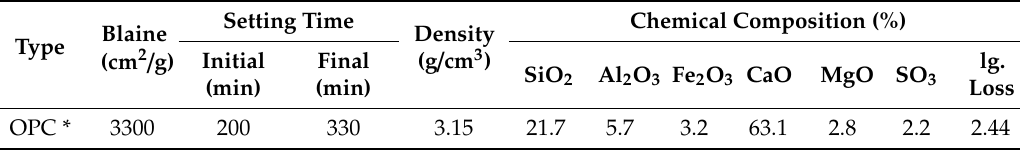
Table 3. Physical properties and chemical composition of OPC.